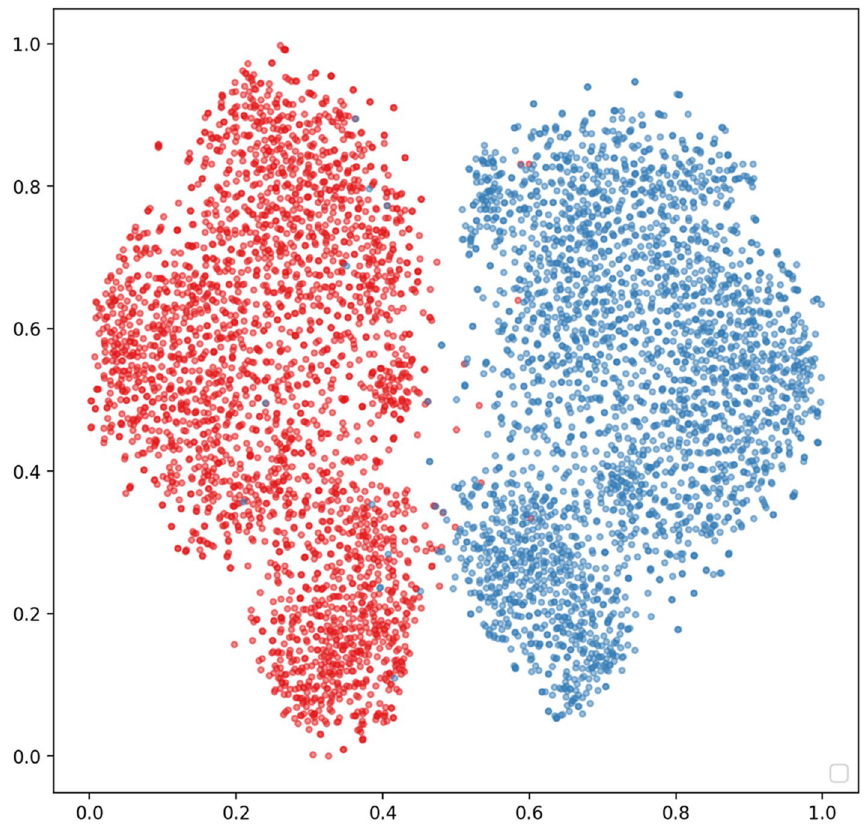
Figure 5. t-SNE plots of features associated to the different types of synthetic images. The red versus blue dots represent hierarchical features extracted from right eye vs. left eye, respectively, of anterior segment photography.